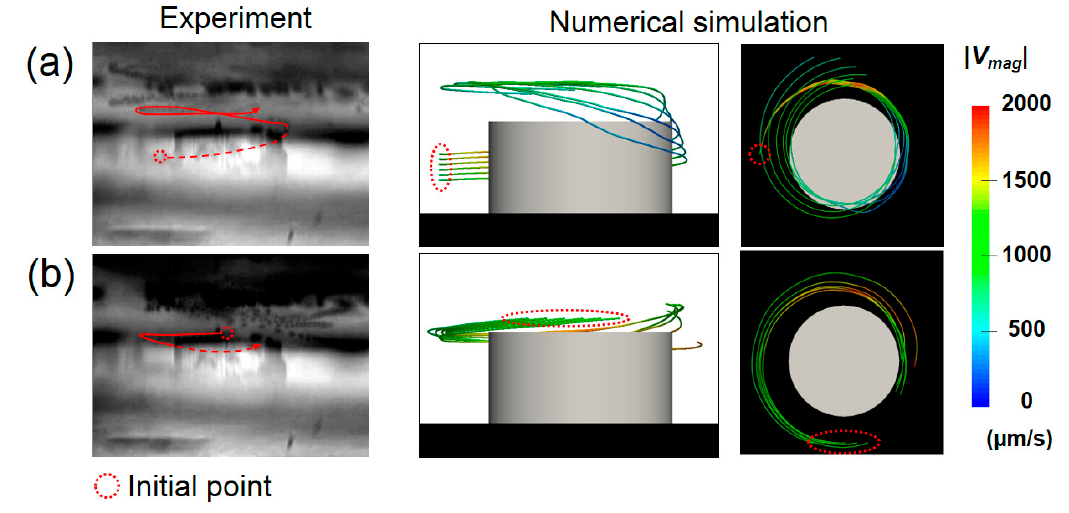
Figure 13. Comparison of particle trajectories obtained in the experiment and the numerical simulation. ( a ) Ascending motion near the apex of the pillar. ( b ) Descending and ascending motion.